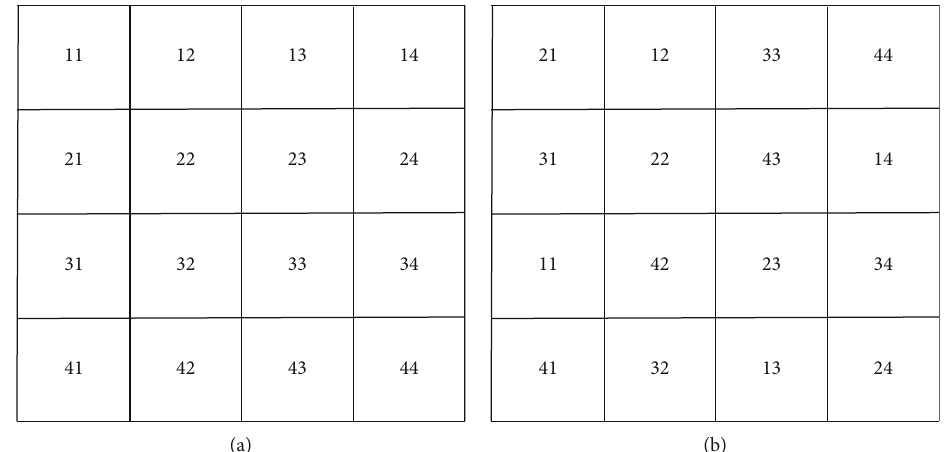
Figure 8: PV cell interconnections: (a) TCT and (b) KDK arrangement.